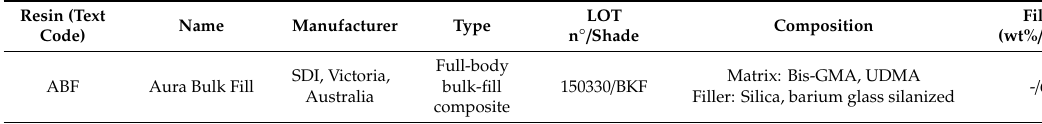
Table 1. Resin-based composites